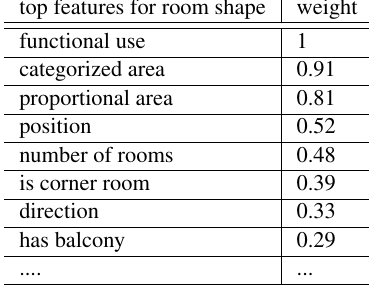
Table 3. Excerpt of the most important features and their weights for the classification of room shapes (L and I).